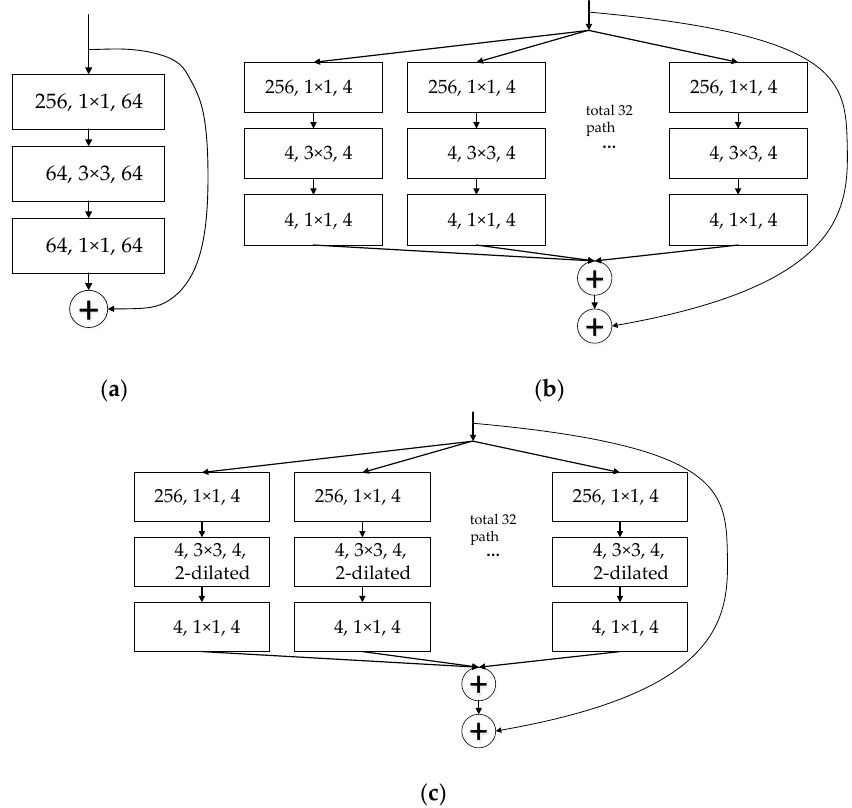
Figure 3. Architecture of different blocks. ( a ) ResNet; ( b ) ResNeXt; and ( c )